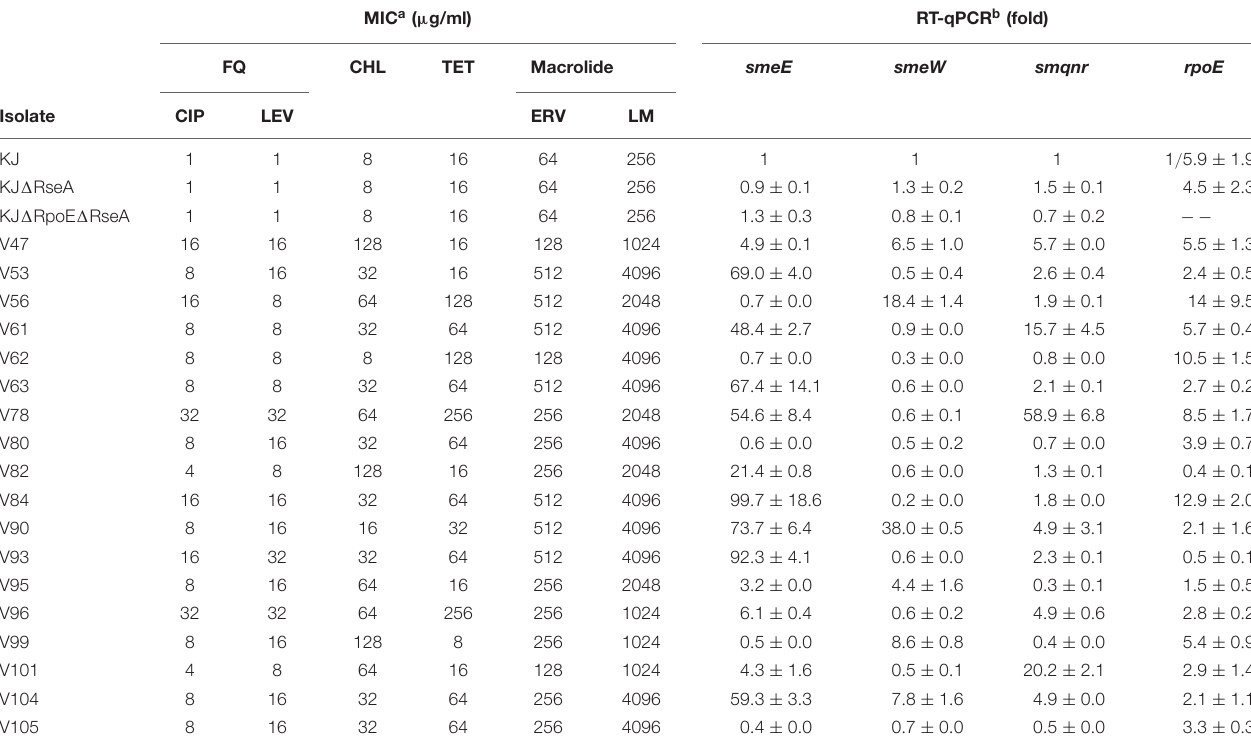
TABLE 1 | Antibiotic susceptibility and the expressions of smeE , smeW , smqnr , and rpoE genes of S. maltophilia isolates.